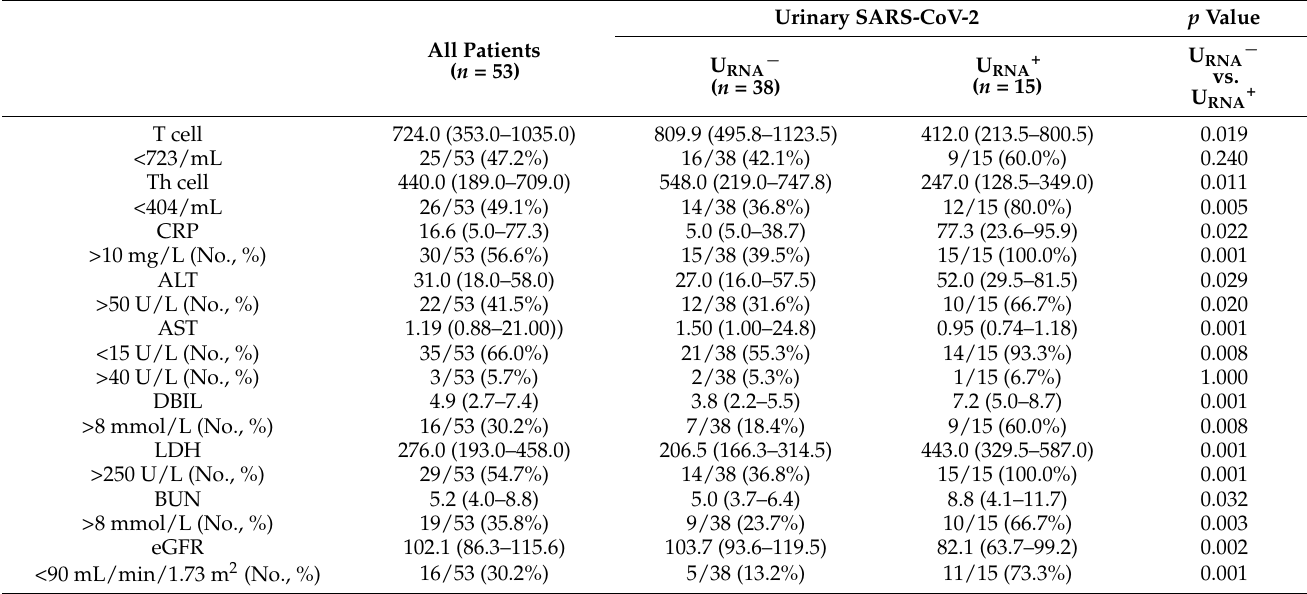
Table 3. Continuous variable results of laboratory tests of COVID-19 patients on admission.